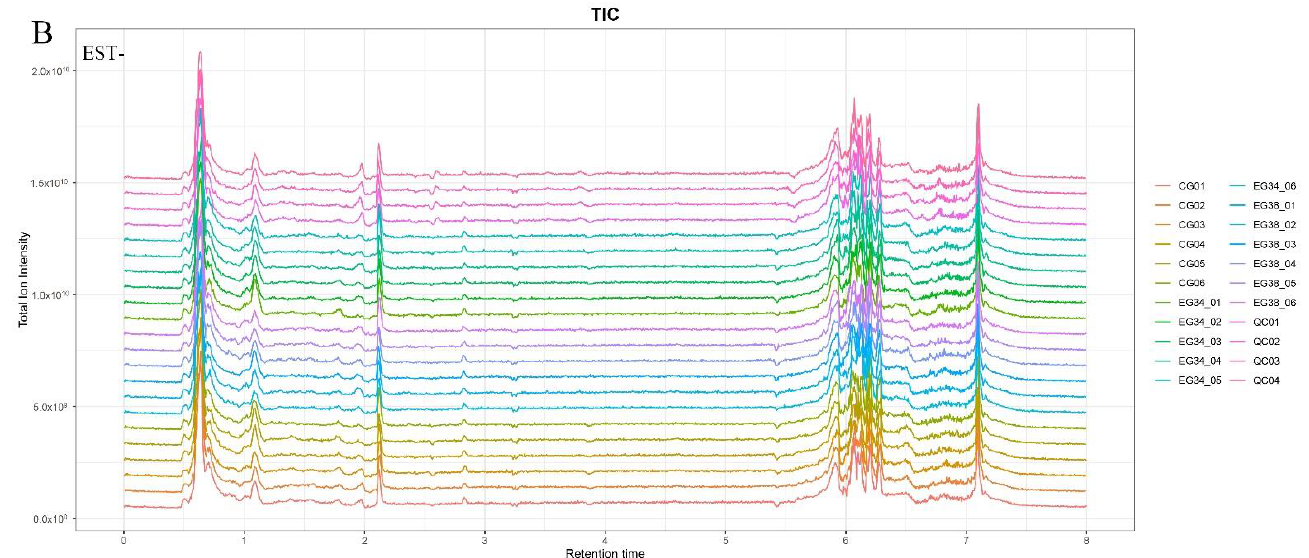
Figure 2. The total ion current (TIC) of liver samples from Cyprinus carpio var qingtianensis measured in ( A ) positive (ESI+) and ( B ) negative (ESI − ) modes. CG01–CG06: six samples from control group; EG34_01–EG34_01: six samples from experimental group (34 ◦ C) under thermal stress; EG38_01–EG38_06: six samples from experimental group (38 ◦ C) under thermal stress; and QC01–QC04: four samples from quality control group.